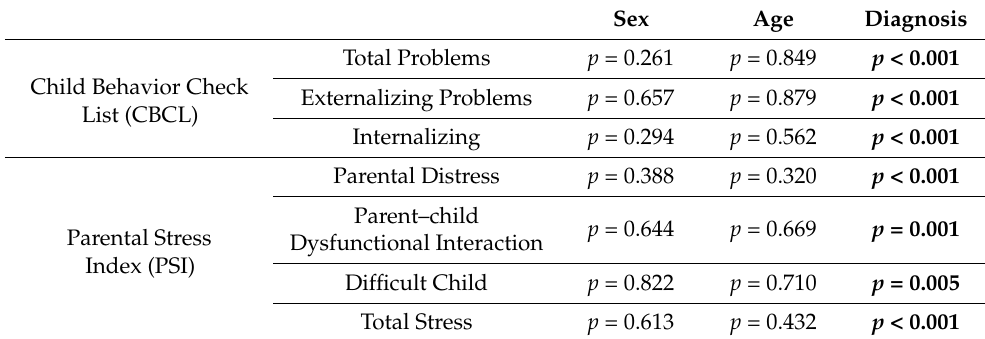
Table 5. Multivariate linear regression analysis between at Time 1. p value < 0.05 are in